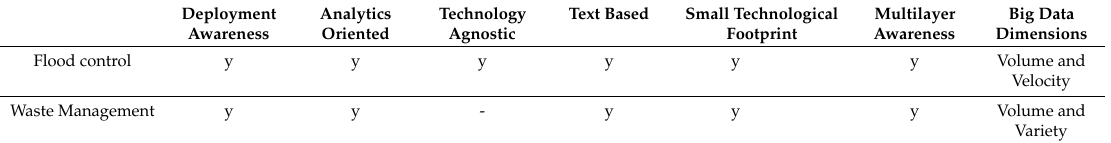
Table 2. PADL functionalities following the criteria of Table 1 validated against the use cases. Deployment